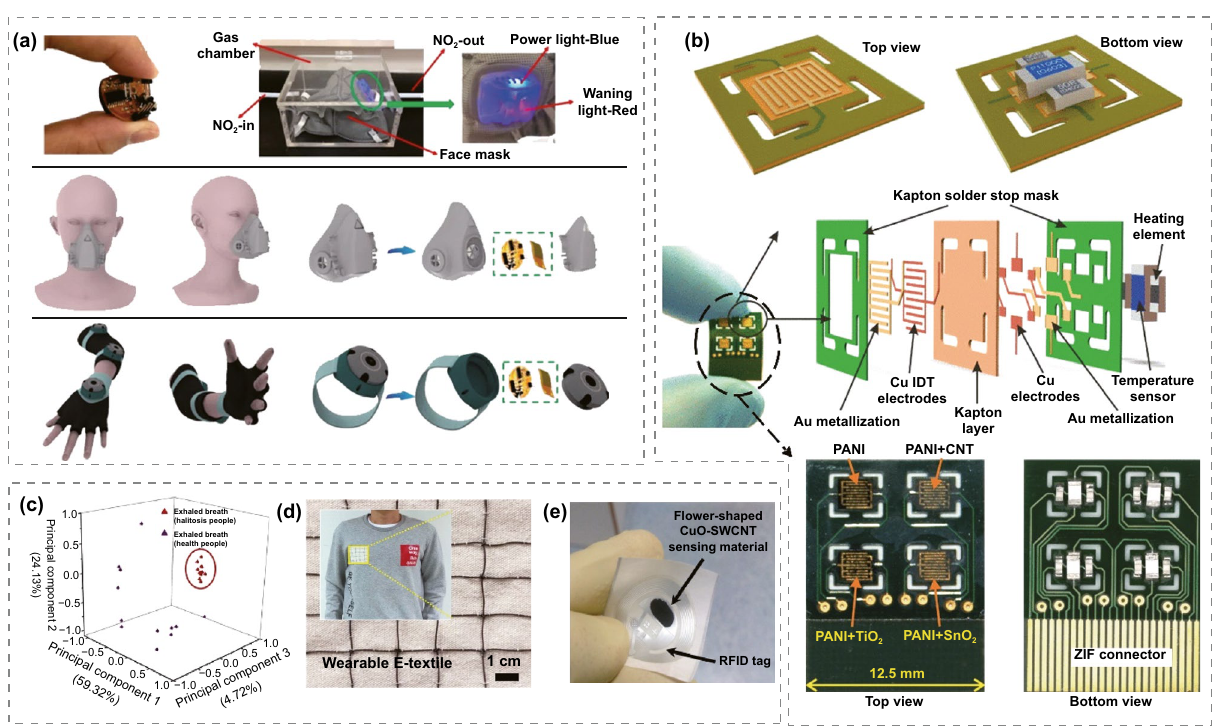
Fig. 11 a The FRT NO 2 monitoring system and wearable applications for smart masks and watches. Reproduced with permission from Ref. [231]. Copyright (2022) Springer Nature. b The expanded view, structural composition, and physical demonstration of the PANI‑based sen‑ sor arrays. Reproduced with permission from Ref. [113]. Copyright (2018) IEEE. c The 3D feature space for principal component analysis of RGO/ZnO hybrid towards different exhaled gases from healthy individuals and patients with halitosis. Reproduced with permission from Ref. [98]. Copyright (2019) Elsevier. d The 5 × 5 gas sensors array networks of the E‑textile. Reproduced with permission from Ref. [54]. Copyright (2019) American Chemical Society. e The optical image of fabricated wireless RFID sensor. Reproduced with permission from Ref. [112]. Copyright (2016)